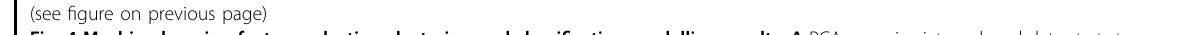
Fig. 4 Machine learning feature selection clustering and classi fi cation modelling results. A PCA on univariate reduced data starts to separate the groups. PCA on the complete functional connectivity data with only univariate reduced features for the alpha band. Three principal components (PC1-3) were plotted. The diagonal shows density distribution of the PCA scores for the four participant groups. The plot shows four participant groups start to separate with univariate reduced data. B SVM CV model classi fi cation accuracy reached comparable values for both feature types. Bar graphs showing per group classi fi cation accuracies for the CV models comparing all seven frequency bands, regional power and functional connectivity. For each participant group , * = statistically signi fi cant ( p â €‰ <â €‰ 0.05) differences based on the ANOVA with Tukey post-hoc test. C Alpha and beta power show robust model versatility. ROC-AUC analysis results for the fi nal regional power model at the alpha and beta frequency bands with the holdout test data. The plot shows that models reached good versatility for both disorders (AUC: 0.7 – 0.9). D Alpha and beta connectivities in the brain are also versatile in differentiating overlapping disorders. ROC-AUC analysis results for the fi nal functional connectivity models for alpha and beta frequency with the holdout test data. The plot shows that models reached good versatility for both disorders (AUC: 0.7~0.8). PCA principal component analysis, PC principal component, ROC receiver operating characteristic, AUC area under the curve, SD standard deviation, NTC non-trauma control, TC trauma-exposed